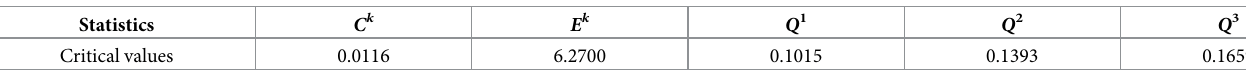
Fig 6. Plots of eye data, (a) Colatitude plot, (b) Longitude plot, (c) Two-variable plot. https://doi.org/10.1371/journal.pone.0273144.g006 Table 5. The (10% upper level) critical values of discordancy tests for n = 23 and κ = 17.9100.